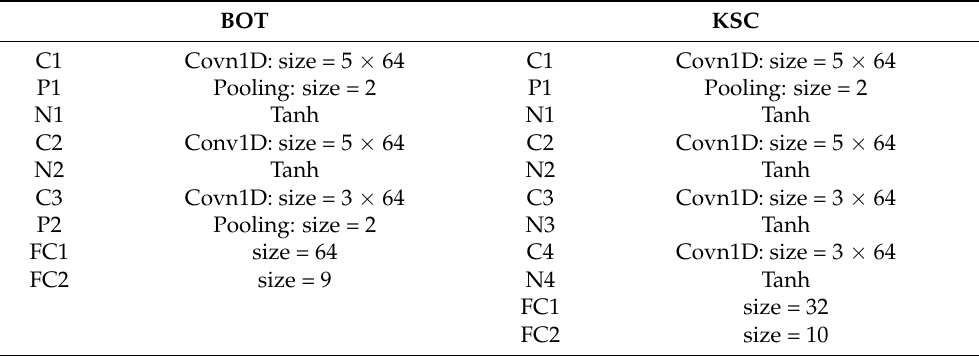
Table 2. Configuration of